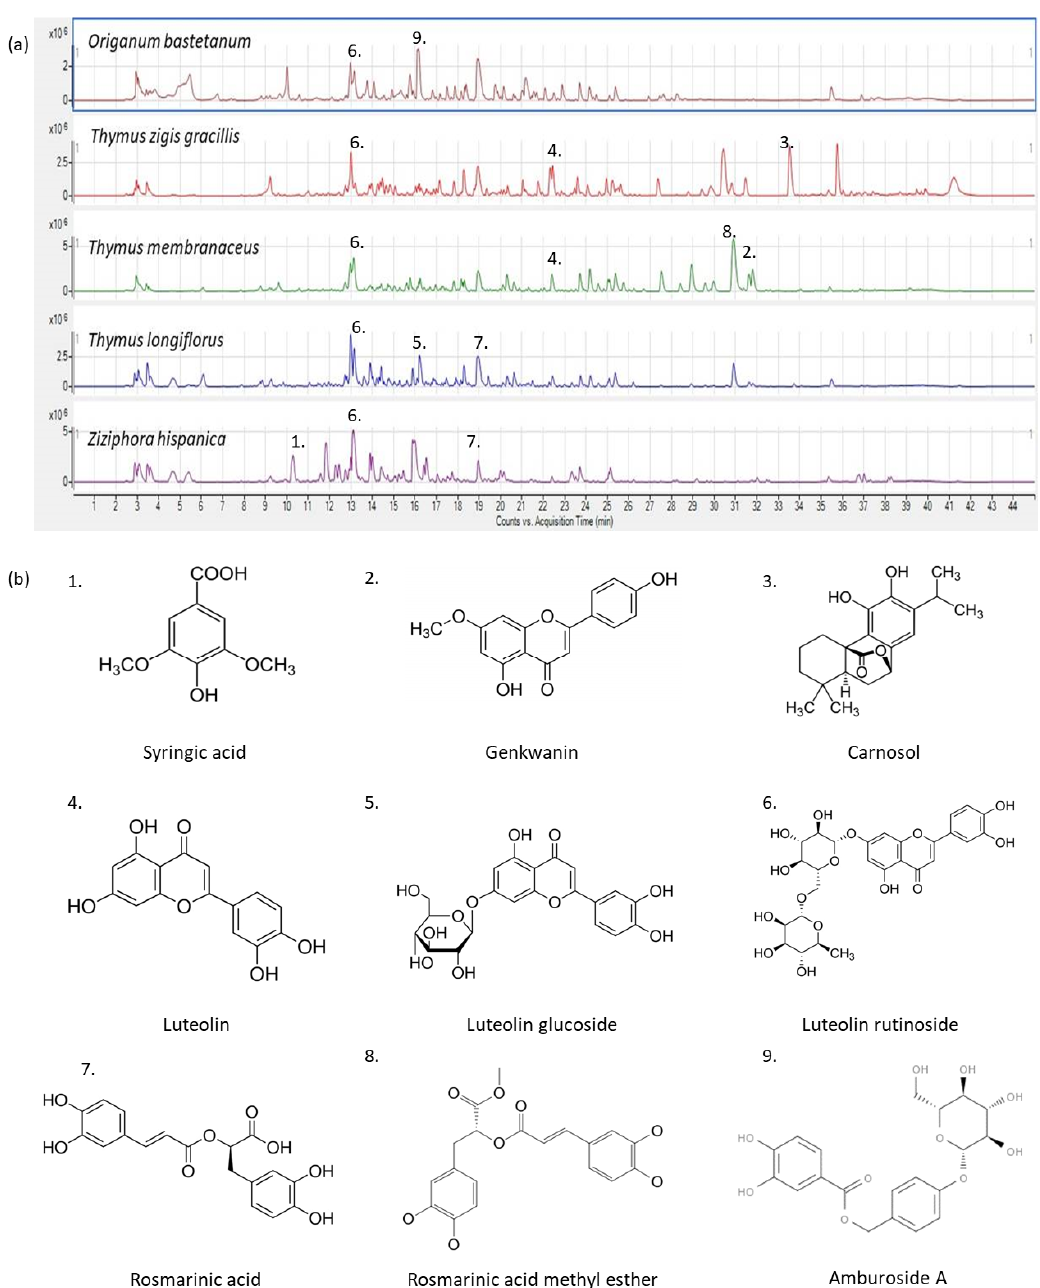
Figure 1. ( a ) Base Peak Chromatograms of MAP extracts with higher bioactivity obtained by HPLC- QTOF-MS; ( b ) chemical structure of some compounds identified in the selected extracts.